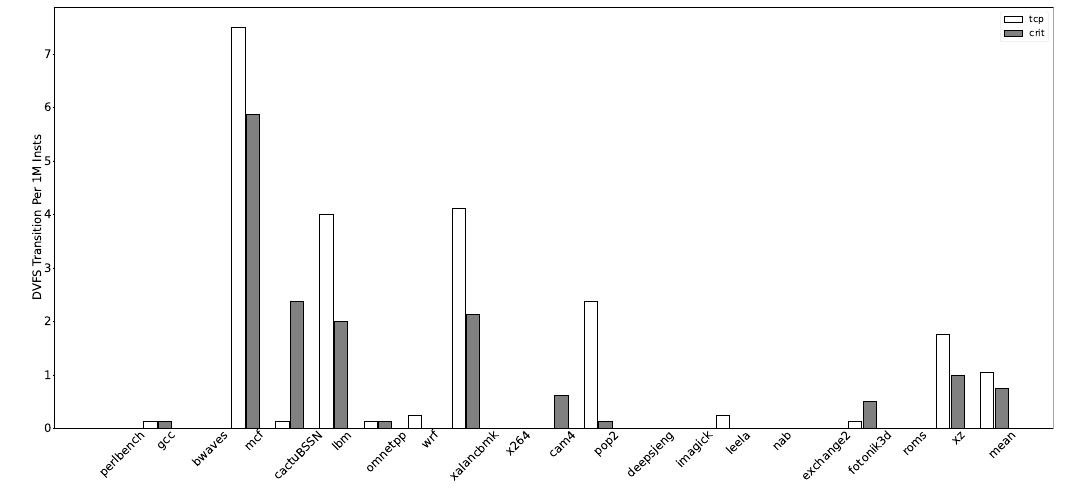
Figure 13. Comparison of the number of DVFS